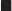
Effects of simazine on phenylephrine (PE)-dependent contractions in the presence (+) or absence (-) of perivascular adipose tissue (PVAT). Summary data for PE induced contractions in (+) PVAT (∙, n = 8 out of four mice) or (-) PVAT (, n = 8 out of four mice) rings. Incubation of the rings with simazine (100 nM, 30 min) had no effects on contractions caused by PE in (+) PVAT (∙, n = 8 out of four mice) and (-) PVAT (, n = 9 out of 4 mice) arterial rings (P > 0.05 each). ∗P < 0.05 for (-) PVAT vs. (+) PVAT or (-) PVAT + Simazine vs. (+) PVAT + Simazine; repeated-measures two-way ANOVA, followed by Bonferroni post hoc test.